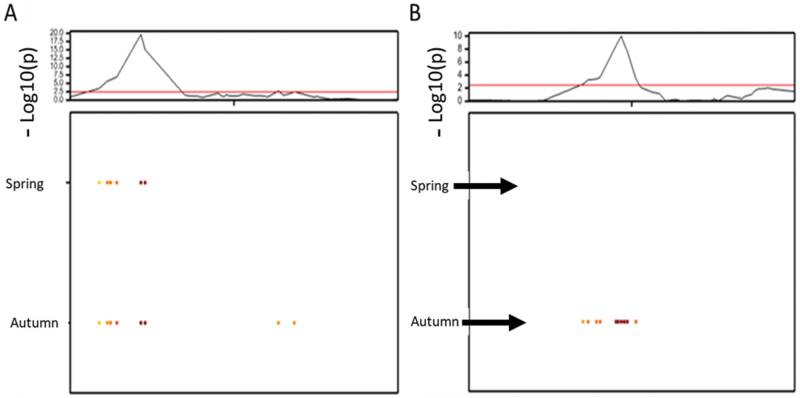
Presence of a QTL for Ht (A) and Hd (B) on chromosome 3A using the data from the 76 BC2F4 population for two trials, spring and autumn sown. The top panel shows the genome-wide profile; the black and red lines indicate the profile of –log10 (P-value) for a composite interval mapping scan. The red horizontal line shows the threshold value for significance (LOD=2.53). Below each graph is a representation of QTL additive effects detected from spring- and autumn-sown experiments. The darker orange/brown colours indicate an increasing additive effect with the Cadenza allele increasing for Ht and Hd.